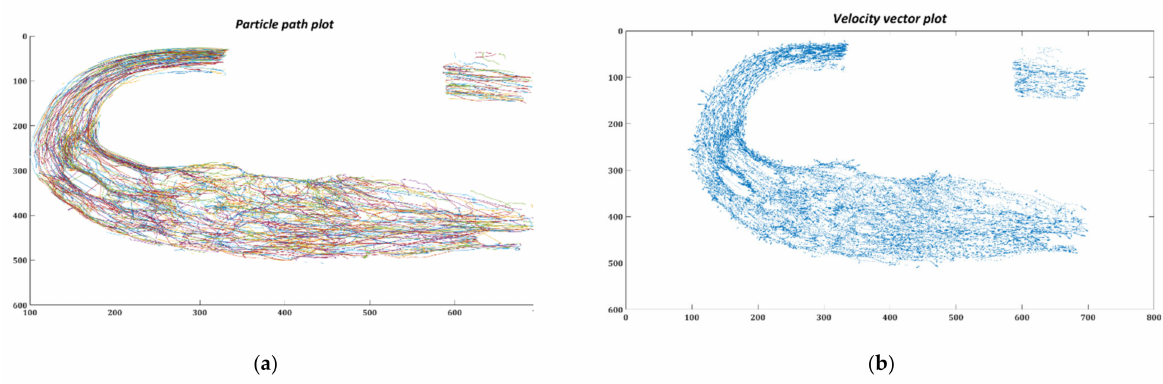
Figure A2. Patient 2 ( a ) Trajectory of the particles ( b ) Flow field of the particles in the MPA